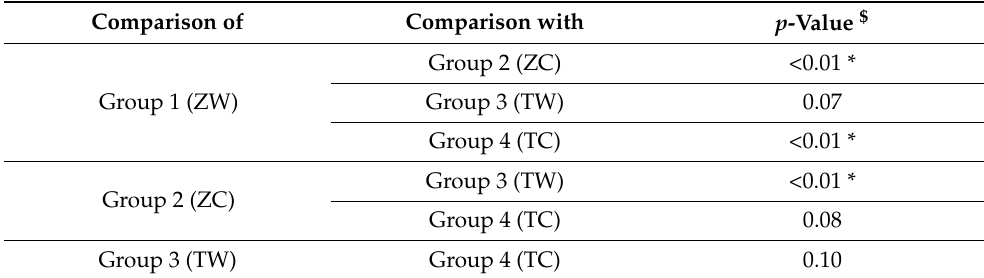
Table 12. Individual group (inter-group) comparison of post-treatment surface roughness (Ra) among study groups. Comparison